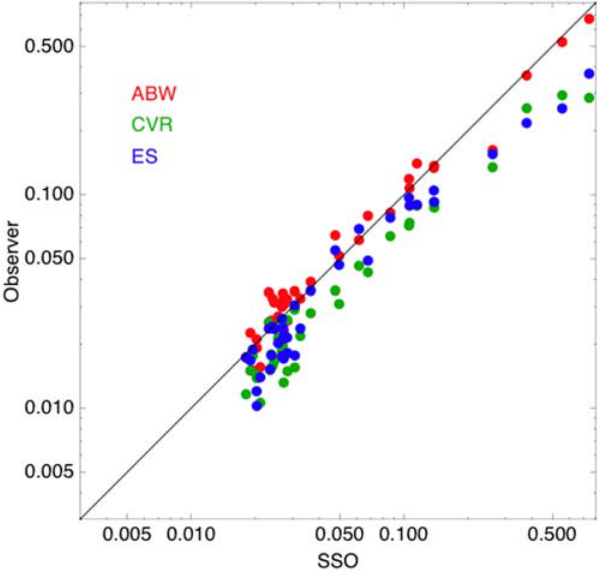
Figure 14. Human observer contrast thresholds versus SSO predictions for both aircraft and Gabor targets. The SSO parameters were re-estimation for each observer to optimize the fit.